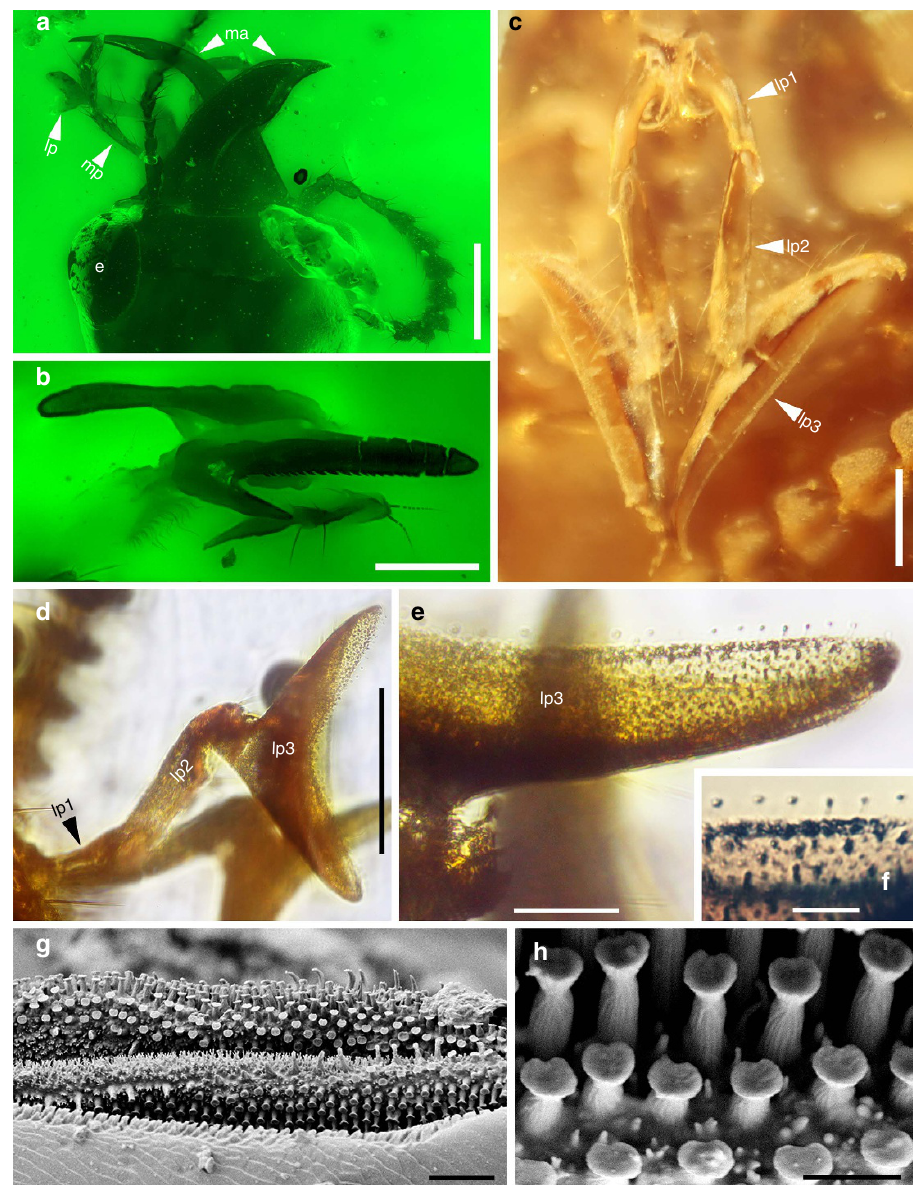
Figure 3 | Details of mouthparts of extinct and extant mycophagous oxyporine rove beetles. ( a , b ) Images under fluorescence, ( c ) under reflected light, ( d – f ) under transmitted light and ( g , h ) under SEM. ( a ) Mouthparts of Taxon 1, NIGP164527. ( b ) Mandibles of Taxon 3, NIGP160556. ( c ) Labial palpi of Taxon 1, NIGP164526. ( d ) Labial palpus of Taxon 2, NIGP164528. ( e ) Enlargement of d showing dense peg-like sensory organs. ( f ) Enlargement of e , showing details of sensory organs. ( g ) Apex of labial palpus of extant Oxyporus sp., showing both peg-like and villiform sensory organs. ( h ) Details of peg- like sensory organs. Abbreviations: e, eye; lp, labial palpomere; ma, mandible; mp, maxillary palpomere. Scale bars, 500 m m ( a ); 200 m m ( b – d ); 50 m m ( e ); 20 m m ( f and g ); 5 m m ( h